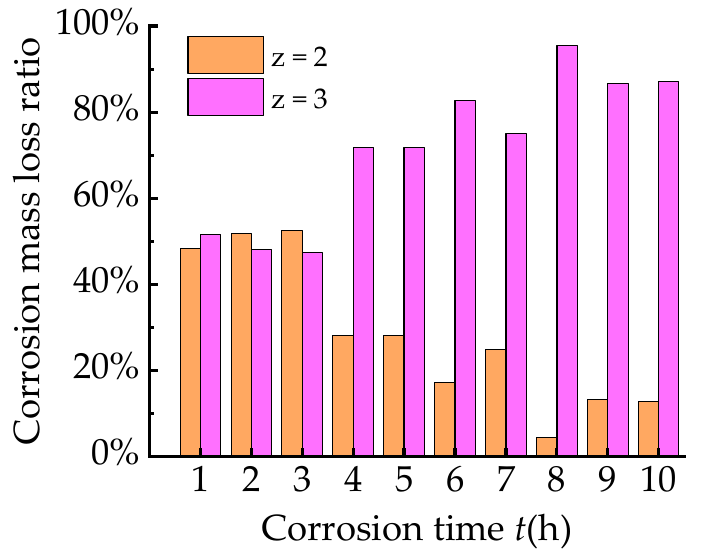
Figure 3. Corrosion mass loss ratio.